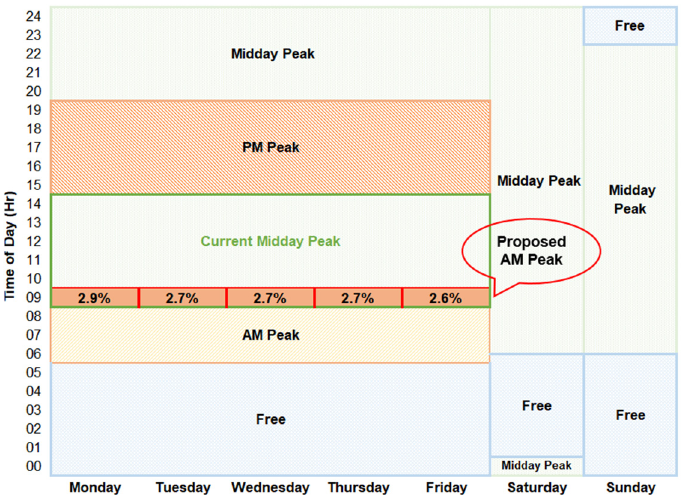
Figure 9. Average vehicular delay reduction after the application of the signal timing plans suggested by the proposed method.